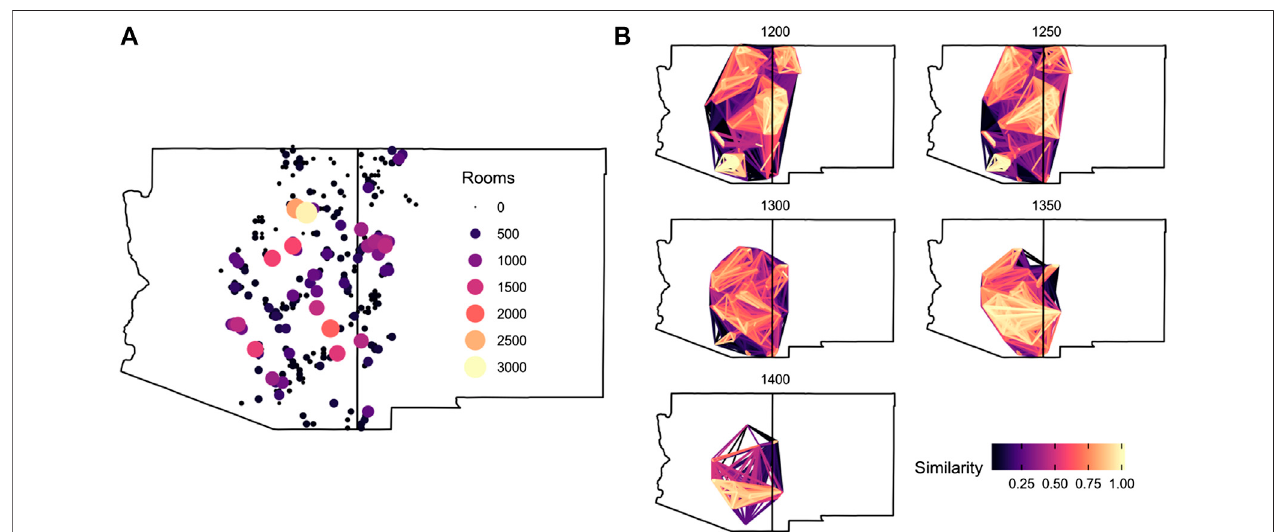
FIGURE 1 | The Southwest Social Networks dataset, version 1.0 (Mills et al., 2013a). (A) Site locations for all time periods in the dataset, aggregated into 10 km patches to reduce biases from local settlement aggregation and dispersal. Site sizes are estimated from room counts. (B) Social networks reconstructed from ceramic assemblage similarity between each pair of sites. A similarity coef fi cient of one means that the sites share the same decorated ceramic wares in the exact same proportions, and a coef fi cient of zero means there is no overlap in the ceramic assemblages. The similarity network can be interpreted as the degree of social interaction and cultural transmission between sites, whether via migration, trade, or copying. Networks are shown over successive 50-year time spans, starting at 1200 CE.